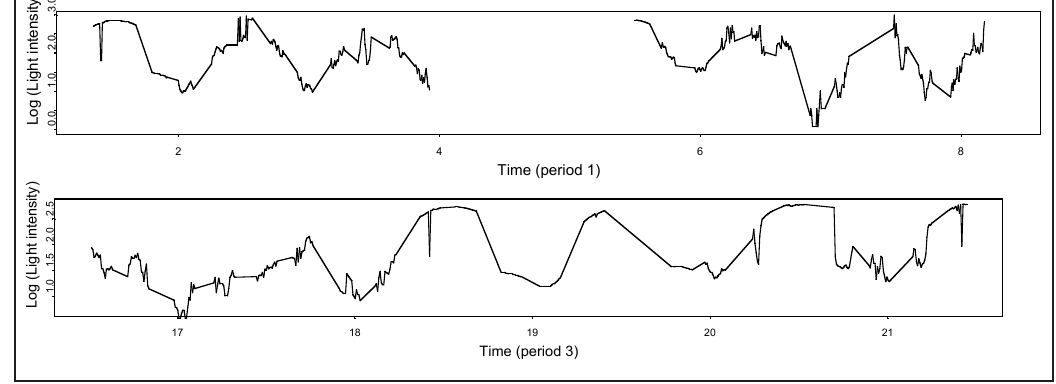
Fig. 3. The 24-hour cycle of solar radiation (light intensity) during periods 1 and 3, Finnmark, June 1999. The change in day (the numbers along the x-axis) represent midnight. Missing data between day 4 and 6 in period 1 was caused by a